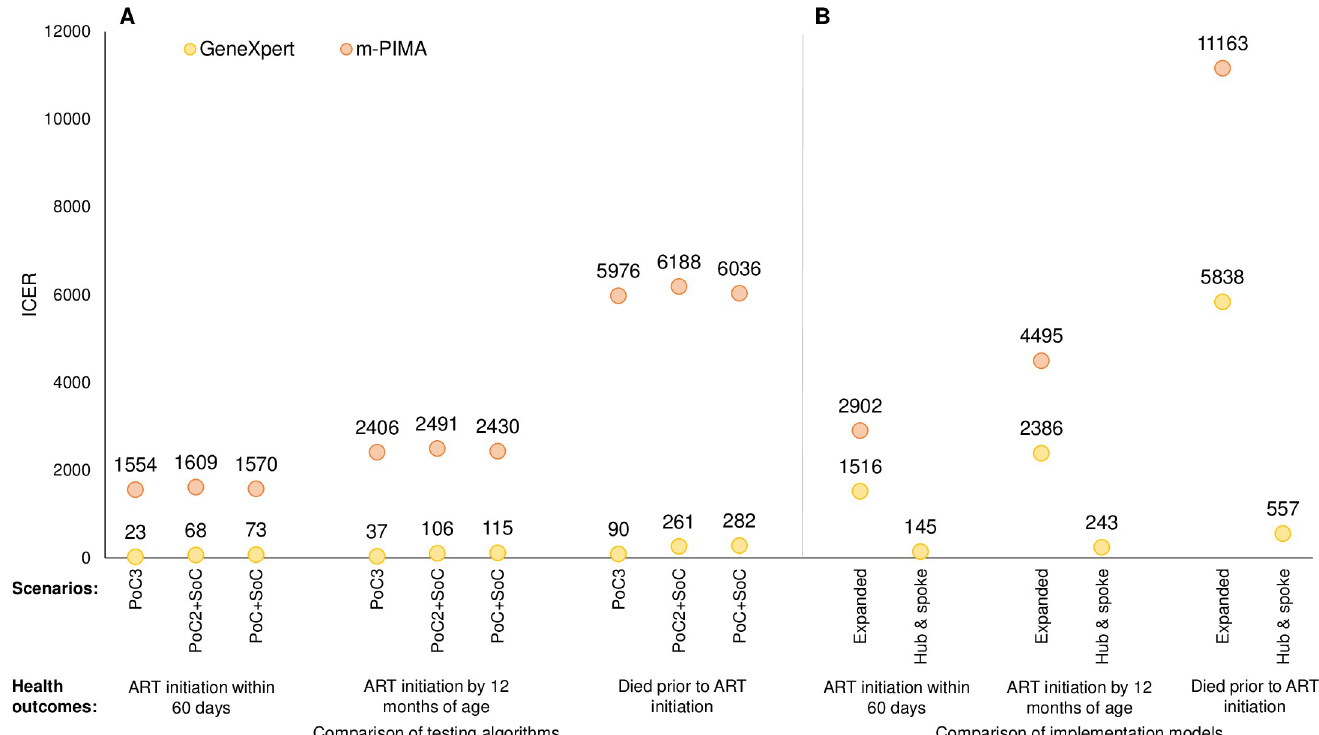
Fig 3. Incremental cost-effectiveness ratios for point-of-care testing by (A) algorithm and (B) implementation model. ART: antiretroviral therapy; ICER: incremental cost-effectiveness ratio; PoC: point-of-care testing; SoC: standard of care testing. Note: (A) testing algorithms are presented for the primary implementation model; (B) implementation models are presented for the PoC3